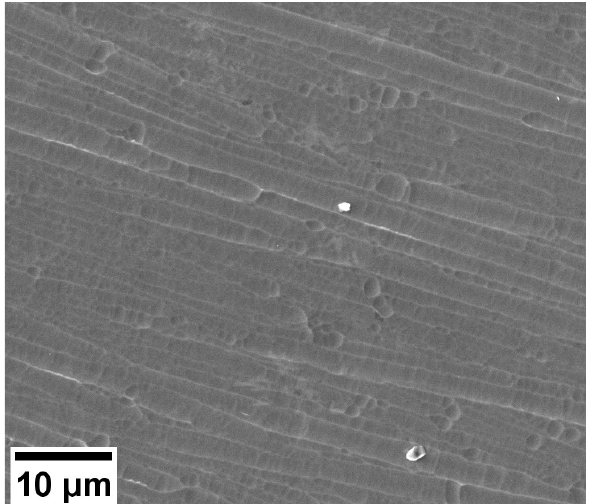
Figure 1. SEM image of the a-C:H:SiO x coating surface on Ti-6Al-4V substrate.